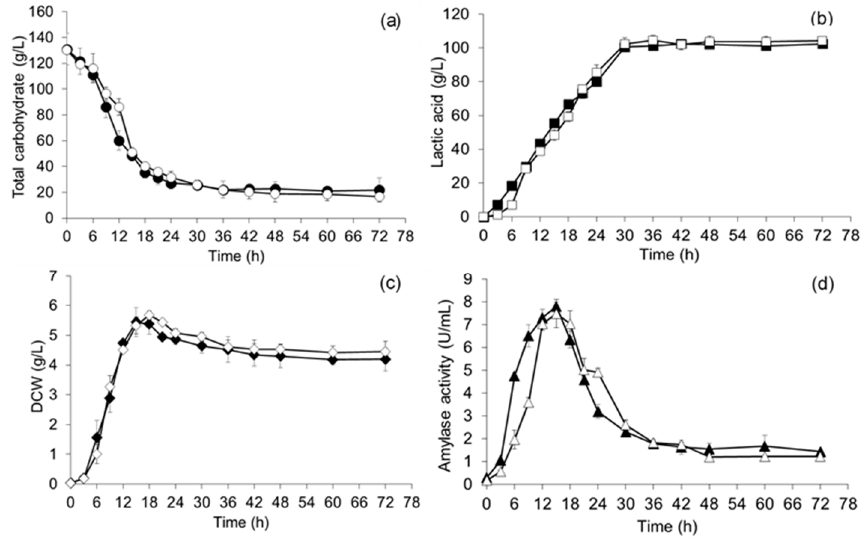
Figure 3. Comparison of lactic acid fermentation by L. plantarum S21 using the optimized medium with minerals (OM) (closed symbol) and without minerals (OM-Mi) (open symbol) in a 1 L fermenter at 37 °C. Time course of total carbohydrate concentration ( a ), lactic acid concentration ( b ), dry cell weight (DCW) ( c ), and amylase activity ( d ).